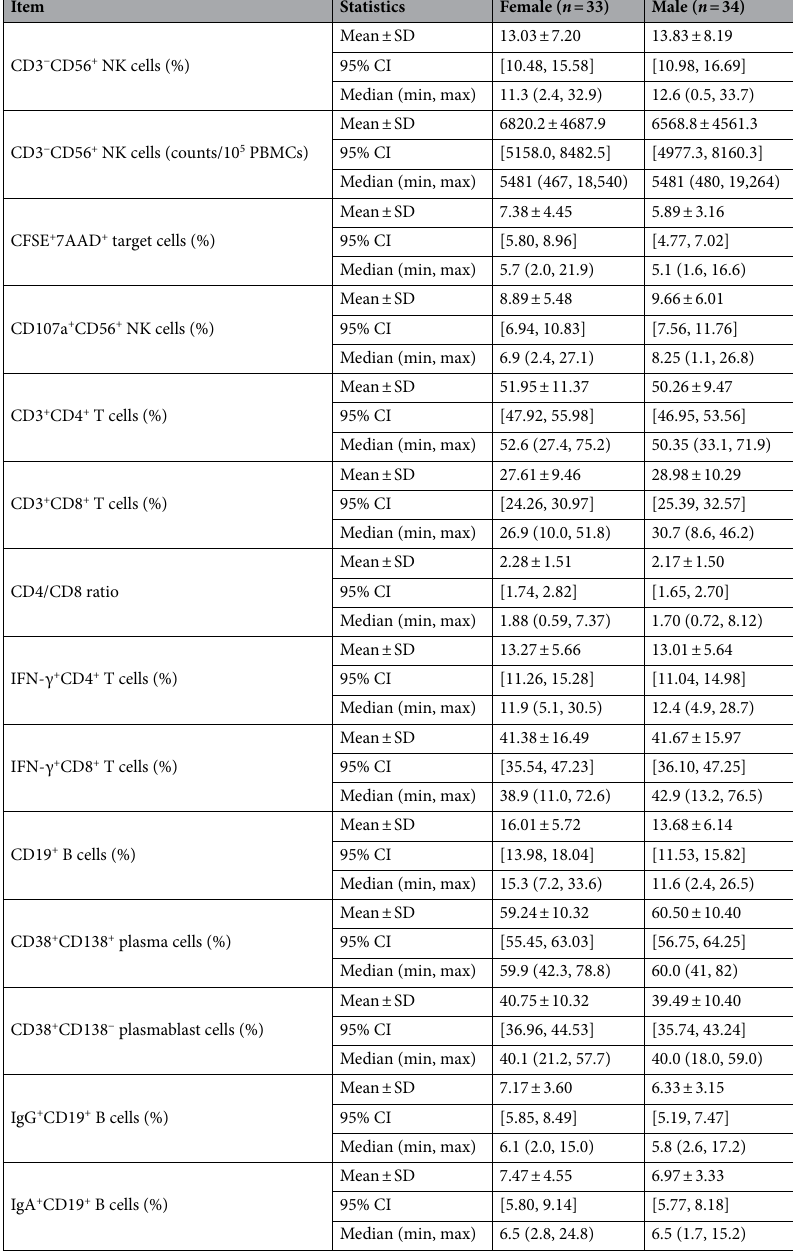
Table 1. Immunological parameters of the study